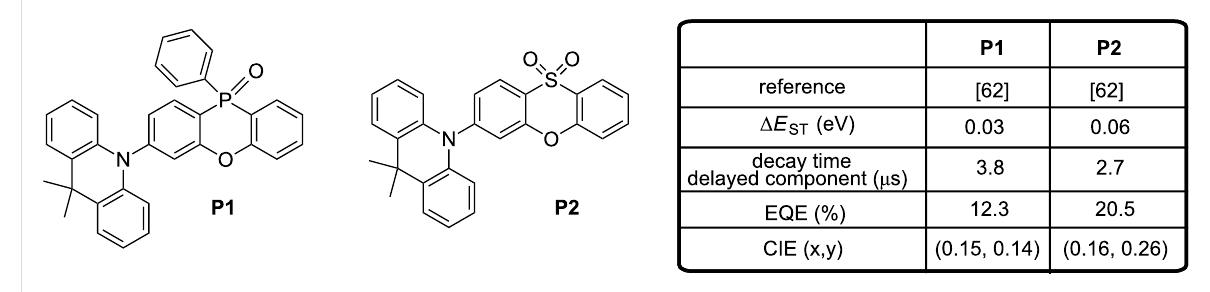
Figure 10: Phenoxaphosphine oxide and phenoxathiin dioxide-based TADF emitters P1 and P2 .